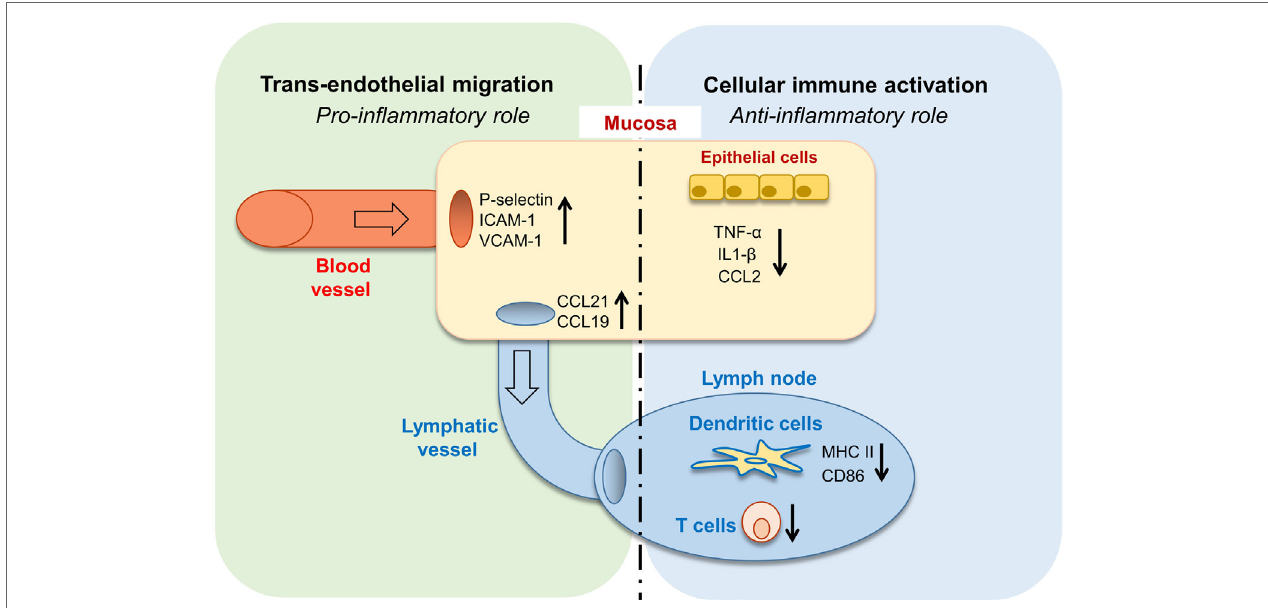
FigUre 8 | Pro- and anti-inflammatory roles for growth arrest-specific 6 (GAS6) in the oral mucosa. Upon infection, GAS6 facilitates extravasation of neutrophils and Gr1 high monocytes to the oral mucosa by upregulating expression of adhesion molecules on blood endothelial cells. GAS6 also enhances migration of mucosal dendritic cells (DCs) to the lymph node by upregulating CCL19/CCL21 expression, chemokines mediating this process via interaction with CCR7 on DCs. Both processes involve the GAS6-mediated trans-endothelial migration, indicating its pro-inflammatory function. On the other hand, GAS6 downregulates the production of pro-inflammatory cytokines and chemokines by epithelial cells. In the LN, GAS6 inhibits antigen presentation and T cell activation by DCs, via reducing expression of the maturation-associated molecules MHC and CD86. Interestingly, CCR7, an additional molecule associated with DC maturation, is not downregulated by GAS6, thus complementing the upregulation of CCR7 ligands by GAS6 in the mucosa to promote migration. Such apparently opposing roles of GAS6 during infection enable the induction of swift innate inflammatory responses, while facilitating the development of a restrained adaptive immune